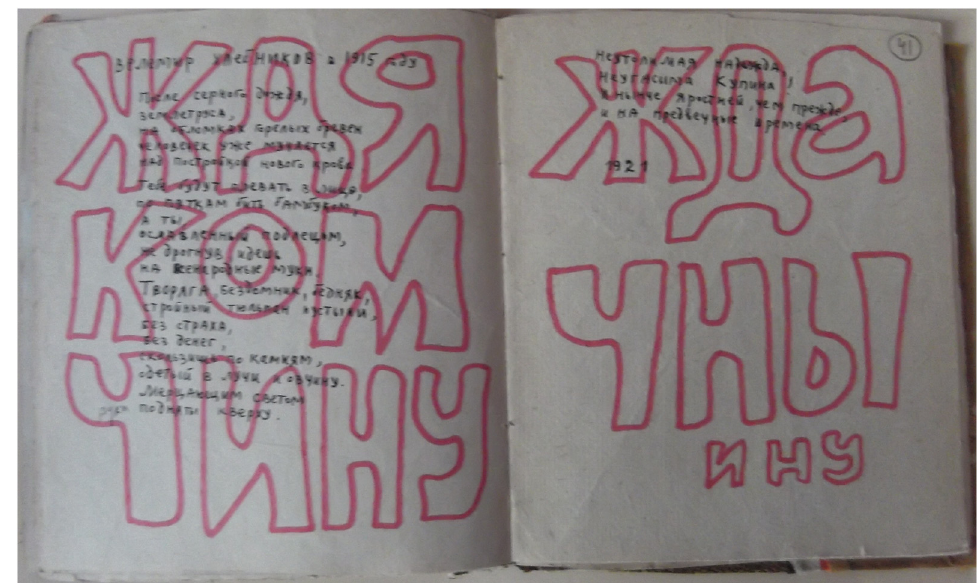
Figure 20. Pages from the fourth booklet.